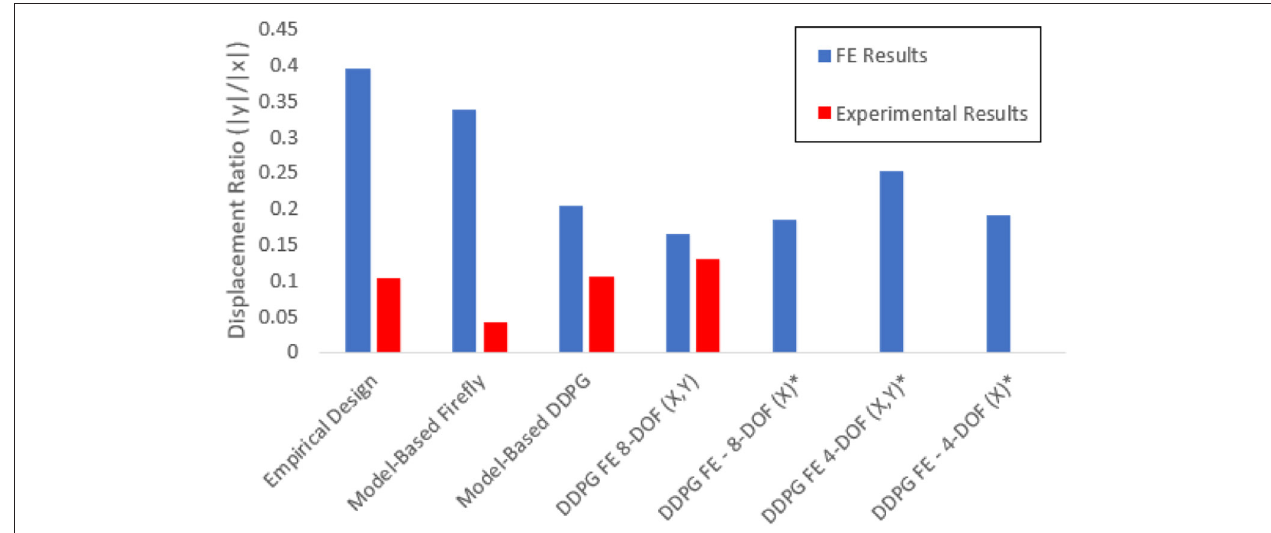
FIGURE 7 | Comparison of the FE and experimental results for the ratio of maximum horizontal and vertical displacements for each design. Various cost function considerations are considered as discussed in the FE computational model for optimization section. Designs that were evaluated only computationally and were not manufactured are designated with *.